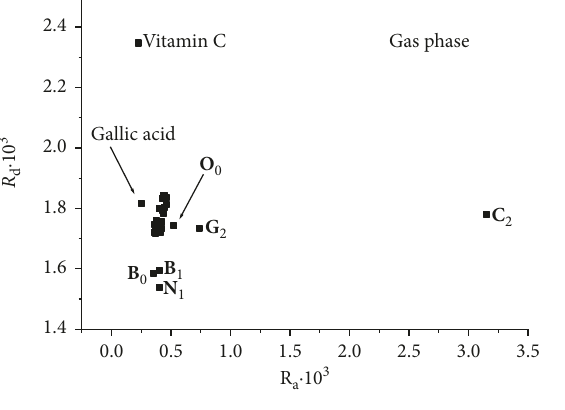
Figure 5: Donor-acceptor maps of anthraquinone derivatives, vitamin C, and gallic acid in gas phase.